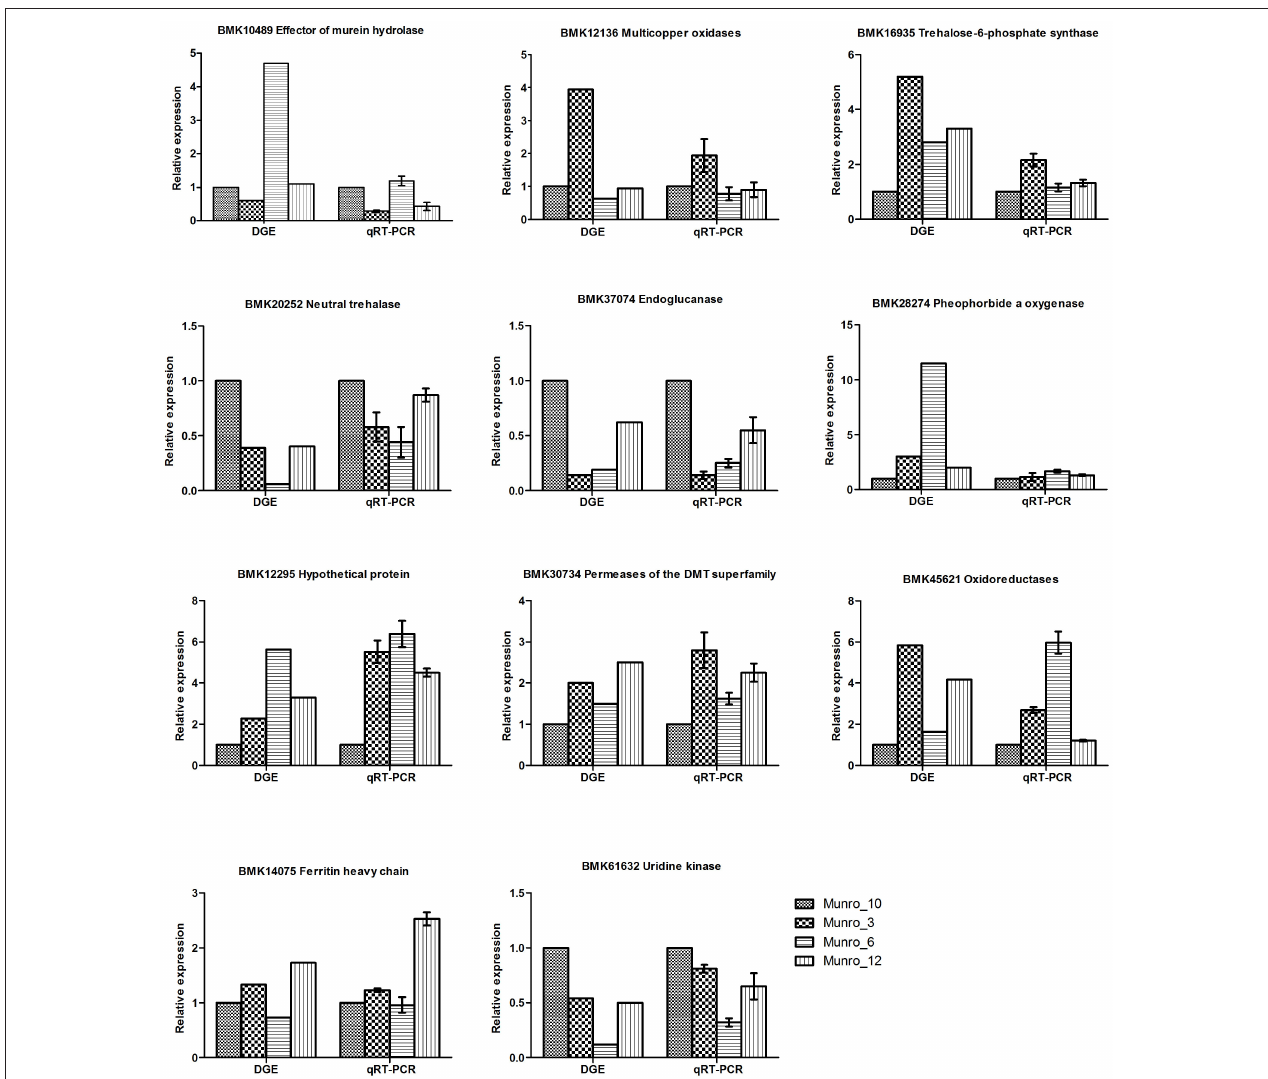
FIGURE 7 | Verification of DGE results by qRT-PCR. Munro_3, triploid (3X); Munro_6, hexaploid (6X); Munro_12, dodecaploid (12X); Munro_10, F1 seedlings (6X).